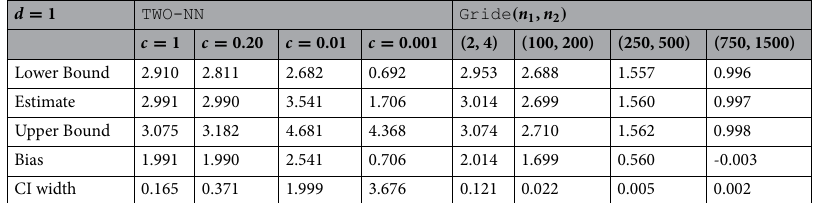
Table 1. MLE point estimates and confidence intervals computed on the Spiral dataset ( d = 1 ) with the TWO-NN and Gride estimators. Different levels of decimation c and different NN orders across the columns. The last two rows report the bias in the estimates, ˆ d